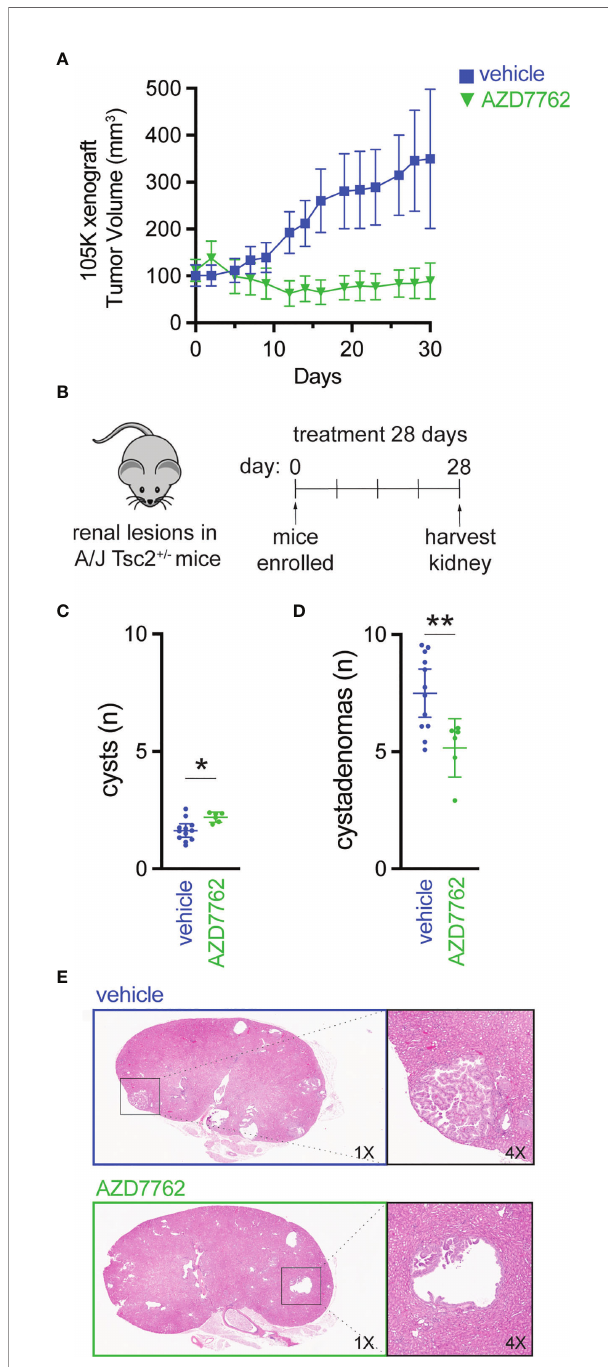
FIGURE 4 | Checkpoint kinaseinhibition as an effective antitumor strategyin preclinicaltumor modelsof TSC2 loss. (A) Tumor volume of 105Kxenografts in BALB/c nudemice treatedonce daily for 28 dayswith either vehicle(n = 14) or AZD7762 (12.5 mg/kg, n = 14); data presented as mean ± 95% con fi dence interval. (B – D) Eight-month-old A/J Tsc2 +/- mice were treated daily with either vehicle(n= 10) or AZD7762 (12.5 mg/kg, n = 10)for 28 days; each treatment group had fi ve maleand fi ve femalemice. Datapresented as mean ± 95% con fi dence interval andanalyzedby one way ANOVA (*p < 0.05; **p < 0.01). (E) H&E-stainedtissue of kidney sectionsfromeach indicated treatmentgroup showinglarge cystadenoma lesion (vehicle) and clearedcyst